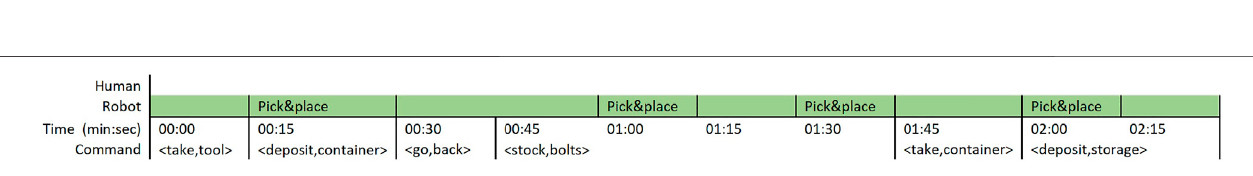
FIGURE 9 | Different stages of the kitting scenario by speech command-based coordination. Left: 00:00 - commands < take,tool > and < deposit,container > are spoken, which instruct the robot to pick and place the tool from the table to the container. Second left: 01:00 - command < stock,bolts > is spoken to instruct the robot to place all bolts from the table into the container. Second right: 02:00 - command < take,container > is spoken to instructtherobottopickupthekitfromthetable.Right:02:15-command < deposit,storage > isspokentoinstructtherobottoplacethekitontheothertable.